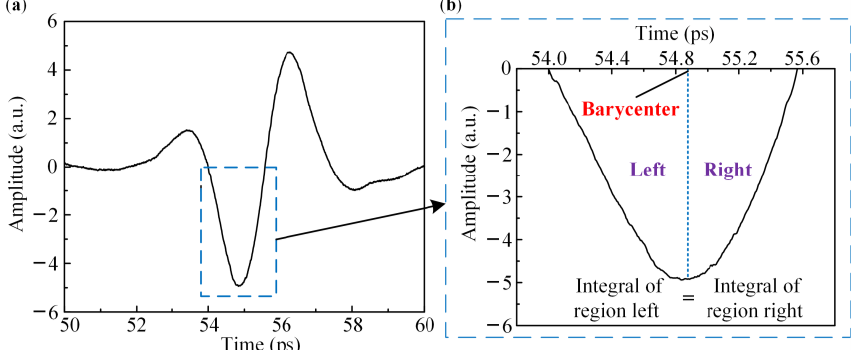
Figure 4. Schematic diagram of the barycenter method. ( a ) the selected THz time-domain spec- trum; ( b ) the position of the barycentric peak.